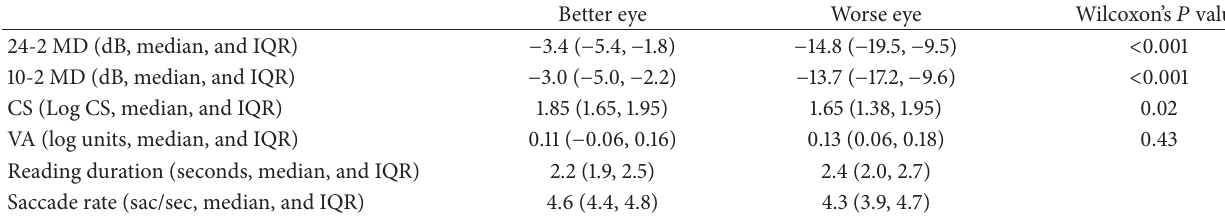
Table 1: Descriptive statistics (median and interquartile range [IQR]) for key measured variables in the worse and better eye. Better eye